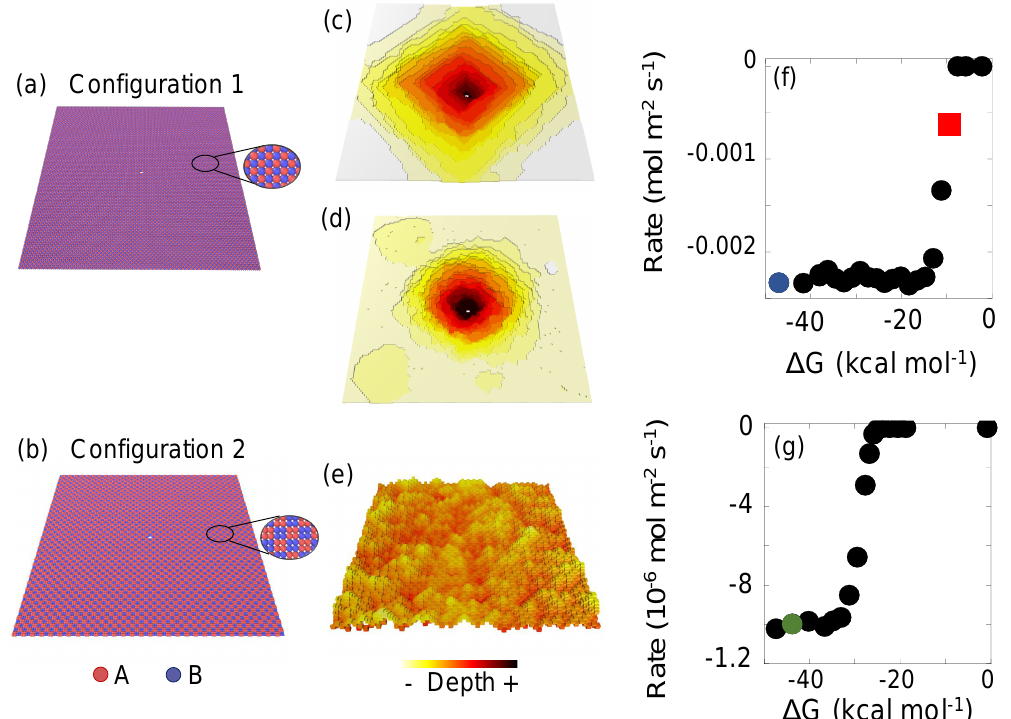
Figure 4. A-B Kossel Crystal studies with ∆ G . ( a ) Initial ‘configuration 1’ system. ( b ) Initial ‘configuration 2’ system. ( c ) Topography of ‘configuration 1’ at the beginning of the onset (red square). ( d ) Topography of ‘configuration 1’ at far from equilibrium conditions (blue point). ( e ) Topography of ‘configuration 2’ at far from equilibrium conditions (green point). ( f ) Dissolution rate versus ∆ G for ‘configuration 1’. ( g ) Dissolution rate versus ∆ G for ‘configuration 2’. The visual representation is done using OVITO program